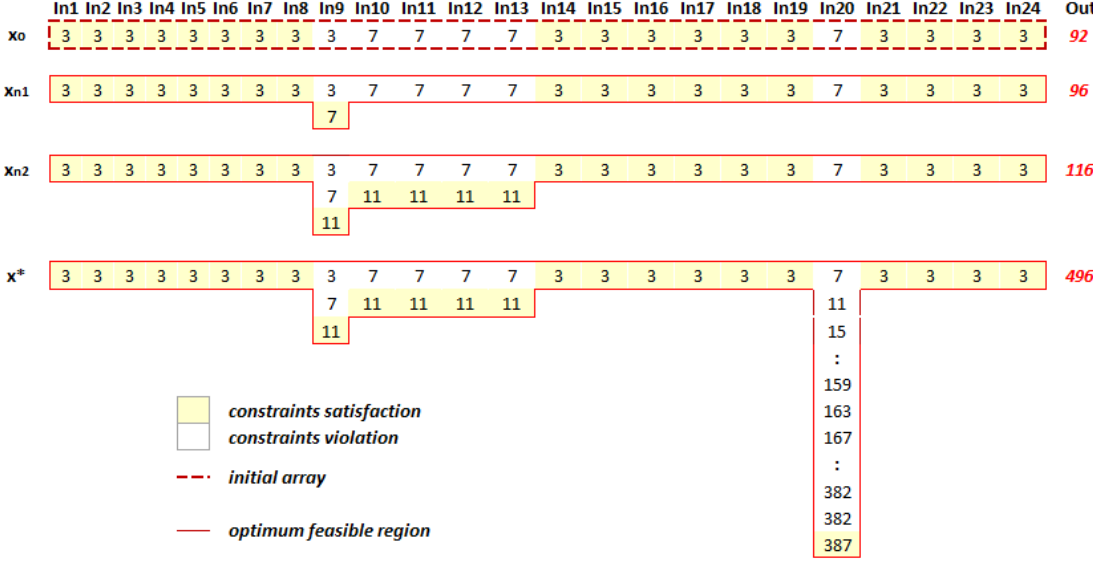
Figure 4. Actual implementation of the proposed BM optimization loop.